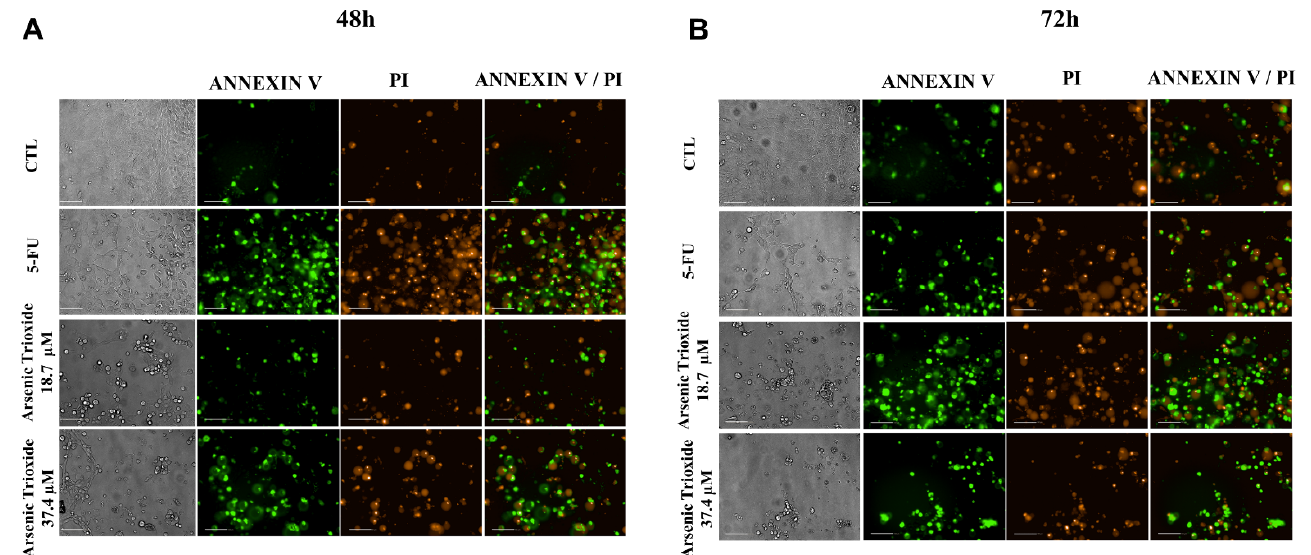
Figure 4. Bright field and representative images of HSC3 cells under early apoptosis, late apoptosis and necrosis after 48 h ( A ) and 72 h ( B ) of treatment, using annexin V-FITC (Green)/Propidium Iodide (PI; Red) (Scale Bar: 100 µm).